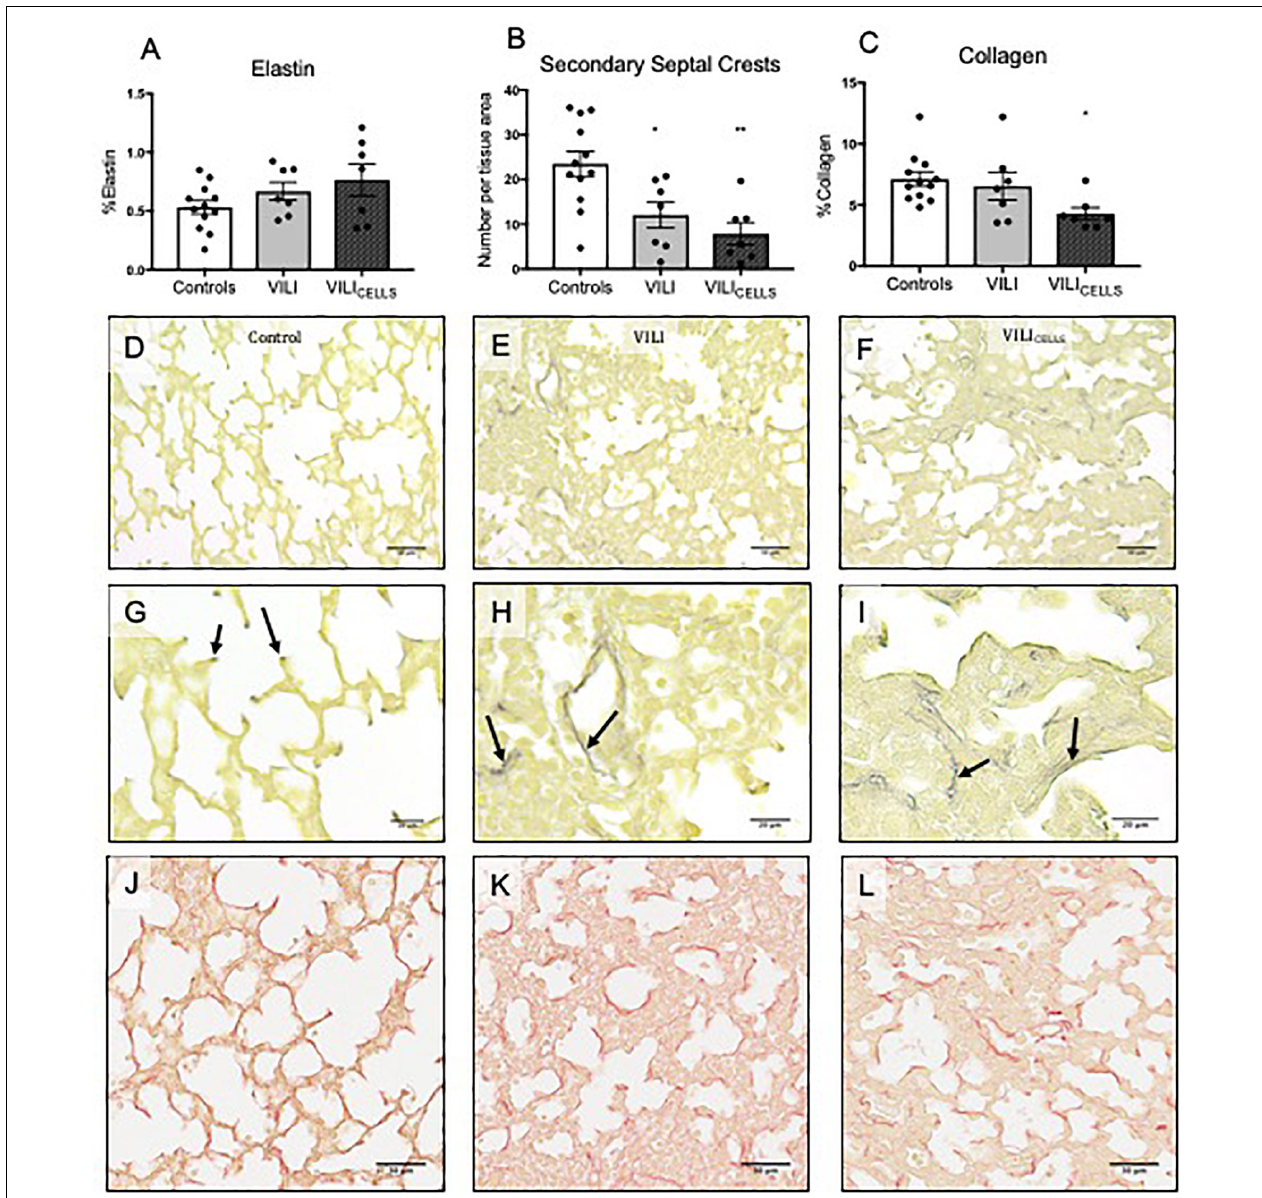
FIGURE 4 | (A) %Elastin content in tissue. (B) Density of secondary septal crests expressed as number per tissue area. (C) %Collagen content in tissue. * P < 0.05, ** P < 0.01 compared to controls. (D–L) Representative lung sections stained with HARTs to view elastin (black staining) in (D,G) control (E,H) VILI, and (F,I) VILI CELLS . Arrows indicate elastin deposition at the points of septa in control lambs, which is irregular in the VILI and VILI CELLS lambs. (J–L) Representative lung sections stained with picrosirius red to view collagen (dark red